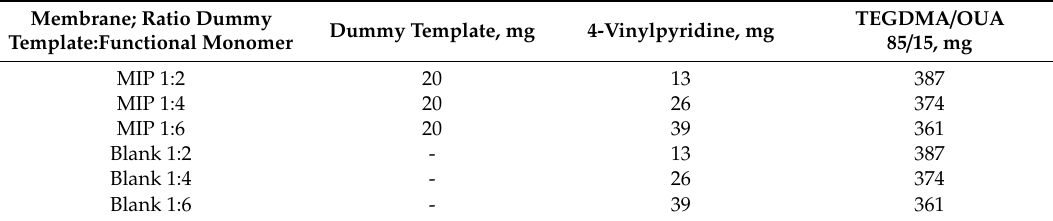
Table 4. Mixture of monomers used for the synthesis of 4-vinylpyridine-containing MIP and blank polymeric membranes capable of zearalenone binding.